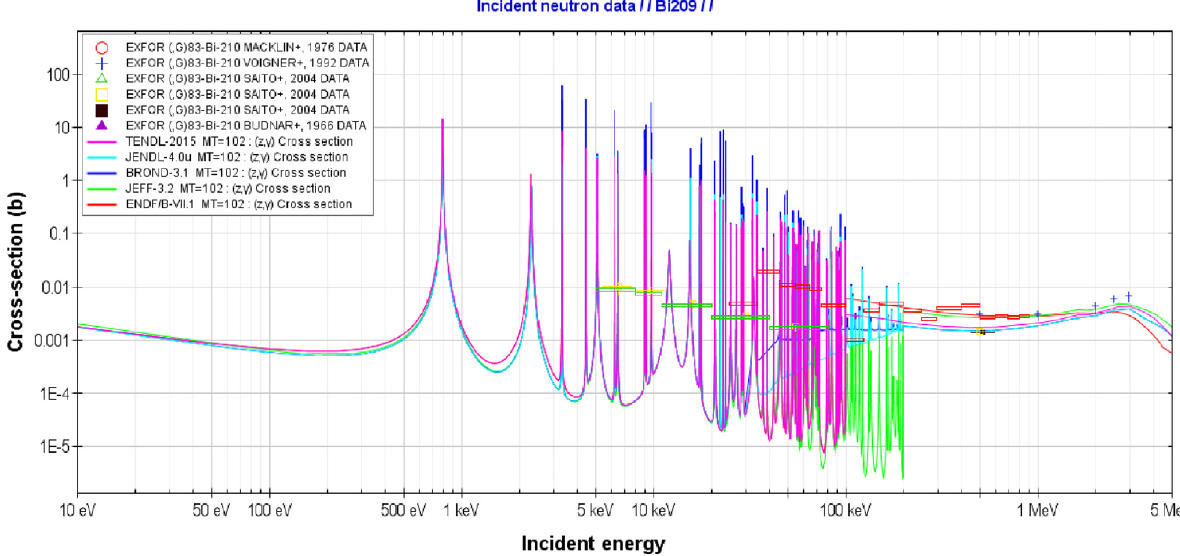
Fig. 2. 209 Bi (n, g ) cross section data: absolute values.